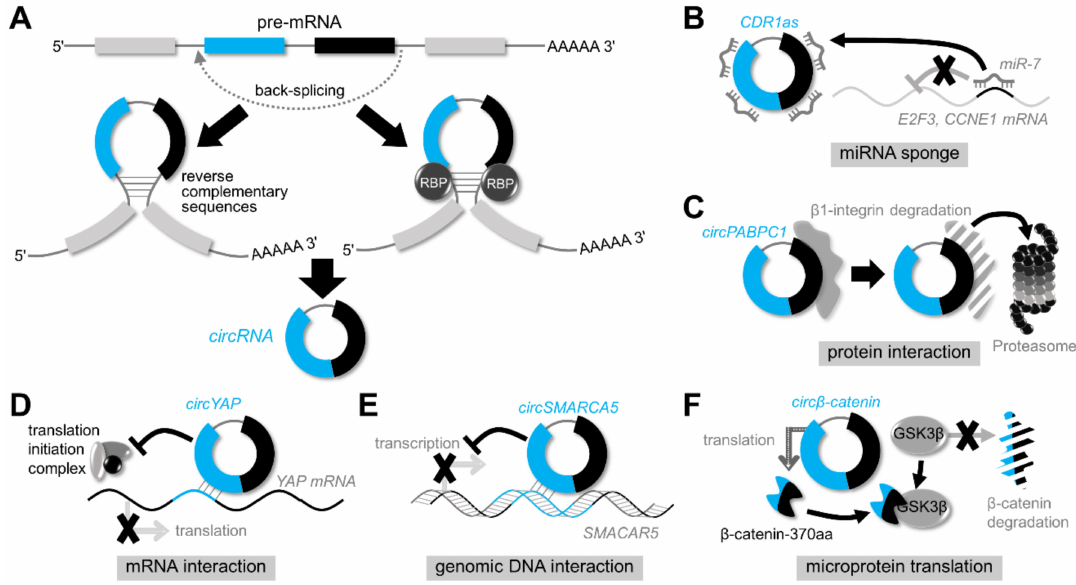
Figure 1. circRNA biogenesis and functions. ( A ) Biogenesis of circRNAs. circRNAs are produced through back-splicing from pre-mRNA transcripts. Back-splicing is facilitated either by reverse complement sequences in flanking introns or by RNA-binding proteins (RBPS) such as splicing regulatory factors, ESRP1, and QKI. ( B – F ) Functions of circRNAs. circRNAs function as miRNA sponges ( B ), interact with other proteins, RNAs, or genomic DNAs ( C – E ), or are translated into microproteins ( F